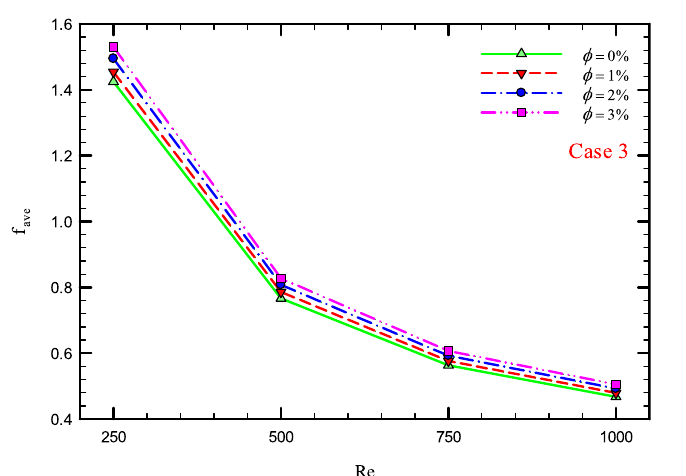
Figure 39. f ave versus Re for Case 3.